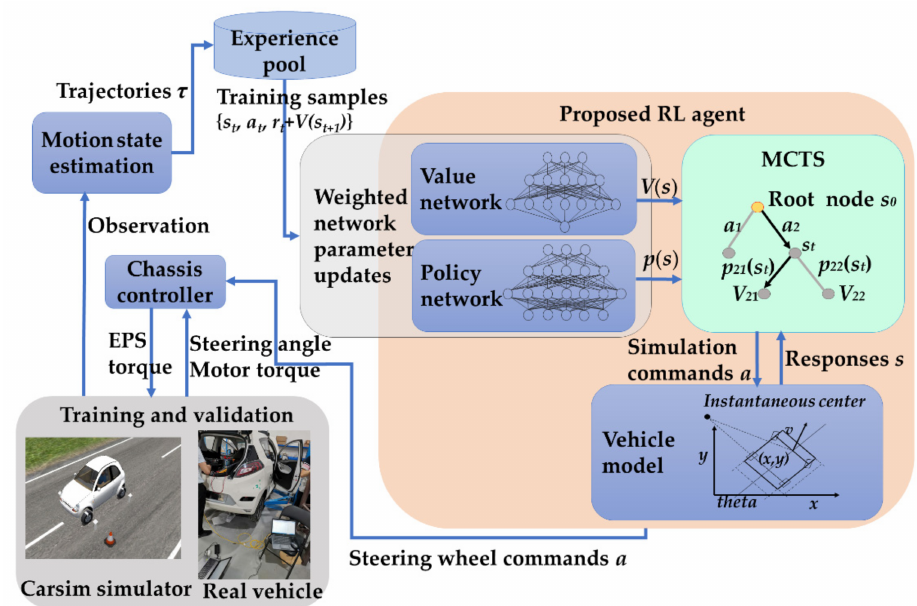
Figure 2. Overview of the reinforcement learning (RL)-based parking architecture in which Monte Carlo tree search (MCTS) was used as the agent. The steering action was realized by the electric power steering (EPS) system. The associated speed command for each steering action is the function of distance, and designed to stop within the safety threshold